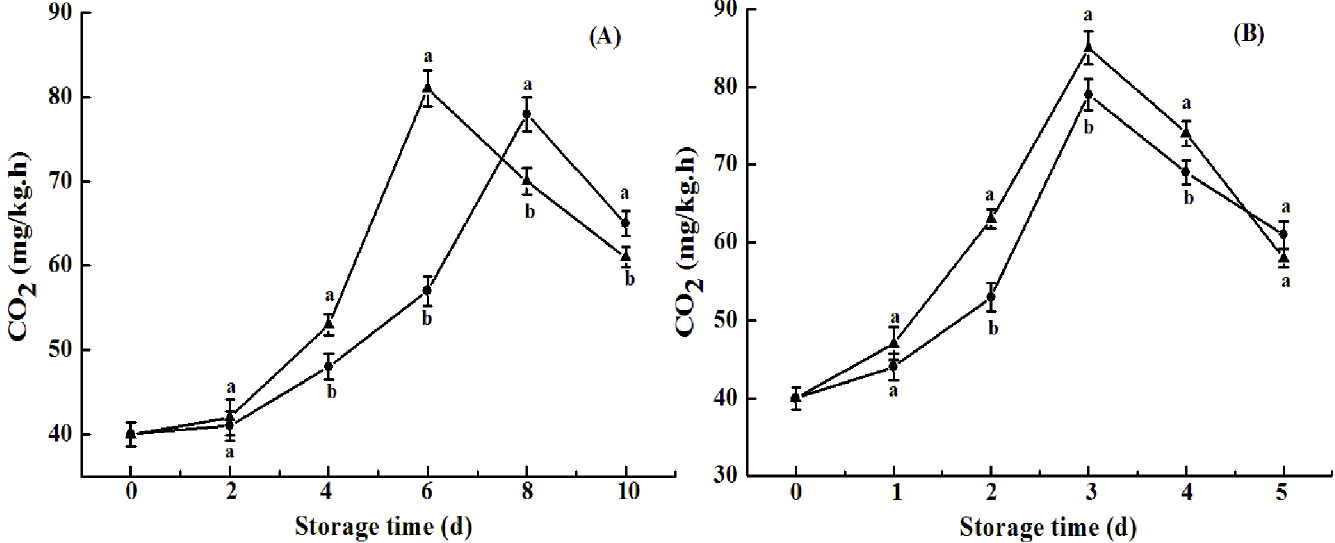
Fig 8. Respiration rate of avocado fruits upon natural (A) or ethylene-induced (B) ripening with ( ● ) or without ( ▲ ) cold shock treatment (CST) during 10- or 5-day storage at 20˚C and 85–90%RH. Vertical bars represent the standarderror of three replicates. Different letters at any storage time indicatesignificantdifferences (P < 0.05).